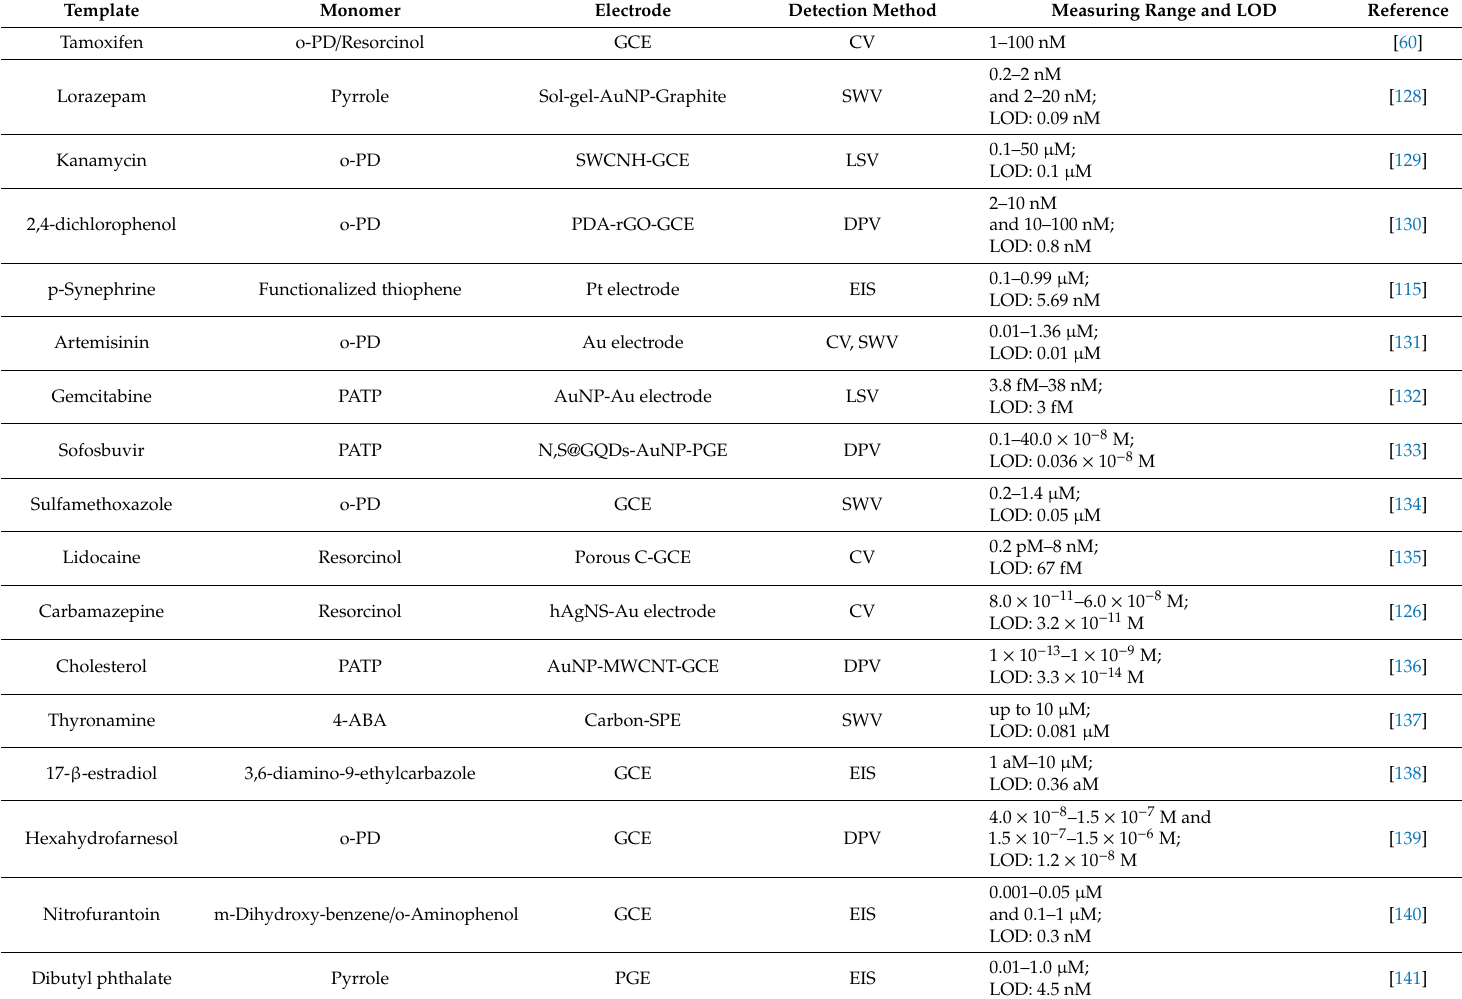
Table 1. MIPs prepared by electropolymerization with electrochemical